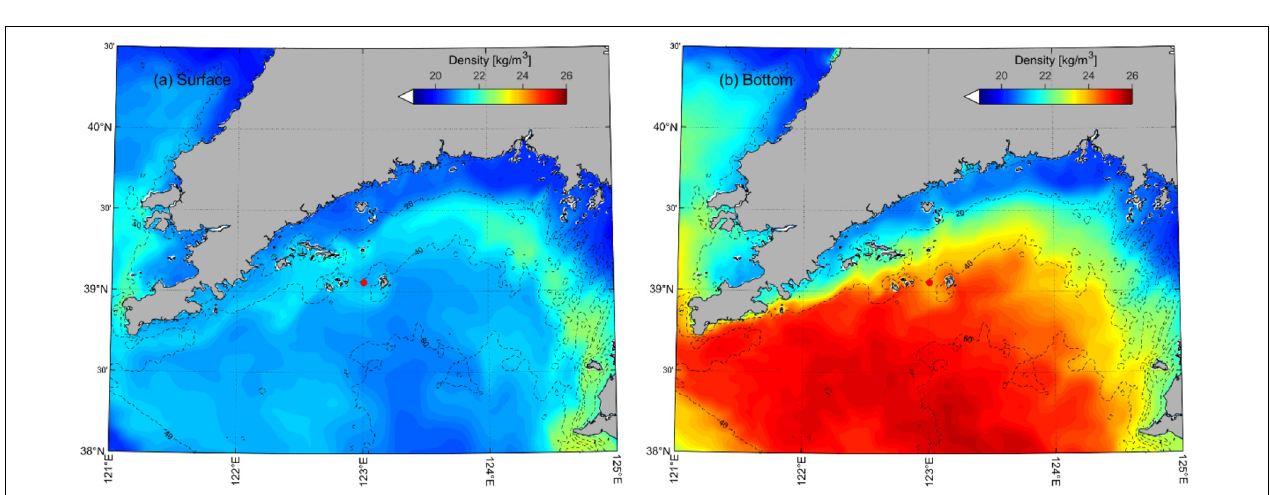
FIGURE 2 | Current directions and magnitudes from the observed (top) and simulated (bottom) total current at different depths (5, 15, and 30 m below surface).